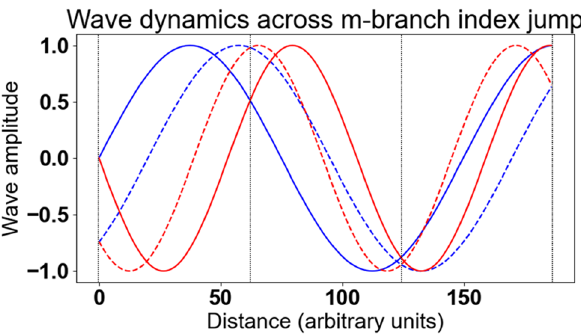
Figure 16. Example of the dynamics of waves across a m-branch index jump. Wave propagation is represented as, for a given color, solid line for the wave position at an instant t and dashed line for the wave position at an instant t + ε. Blue wave represents propagation in a medium with positive refractive index (i.e. wave fronts moving towards the positive z), Red wave represents propagation in a medium with negative refractive index after m-branch index jump (i.e. wave fronts moving towards the negative z). Vertical dashed black lines indicate the boundaries of each unit cell, where the phase of blue and red waves match at any